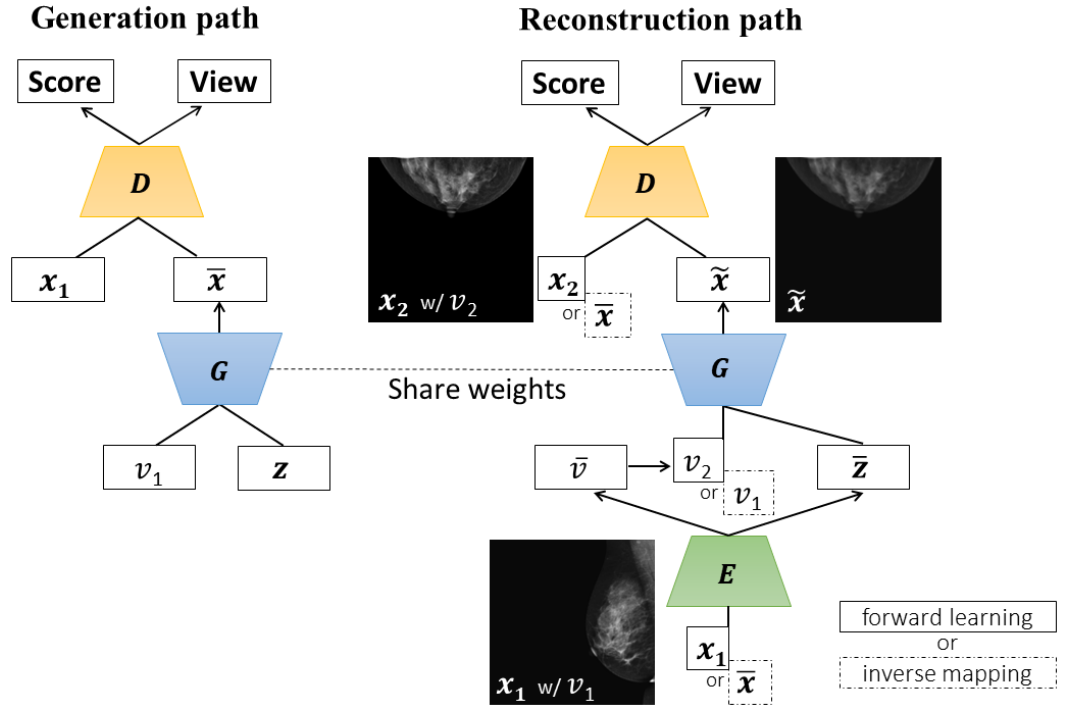
Figure 1. Our training networks based on the CR-GAN framework. In the reconstruction path, the inputs and outputs of each network vary, depending on whether there is a forward learning or inverse mapping